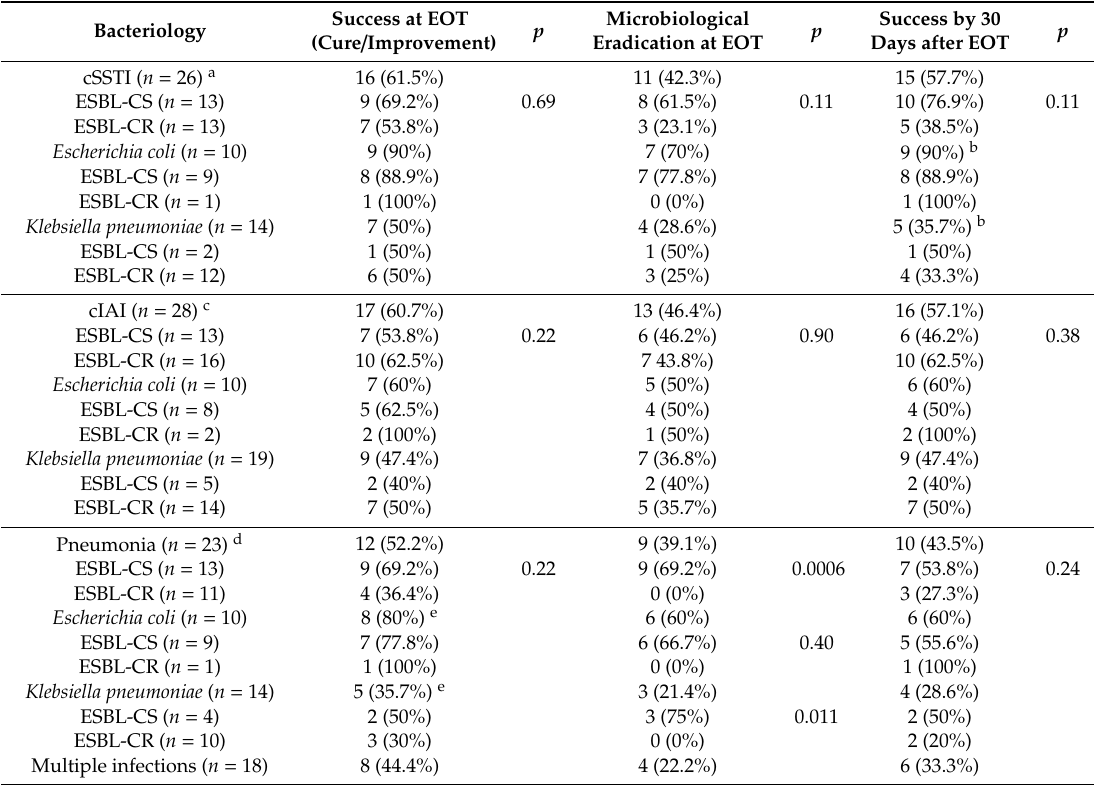
Table 2. EOT outcome and success (survival without readmission) by 30 days after EOT for patients with cSSTI, cIAI or pneumonia stratified by